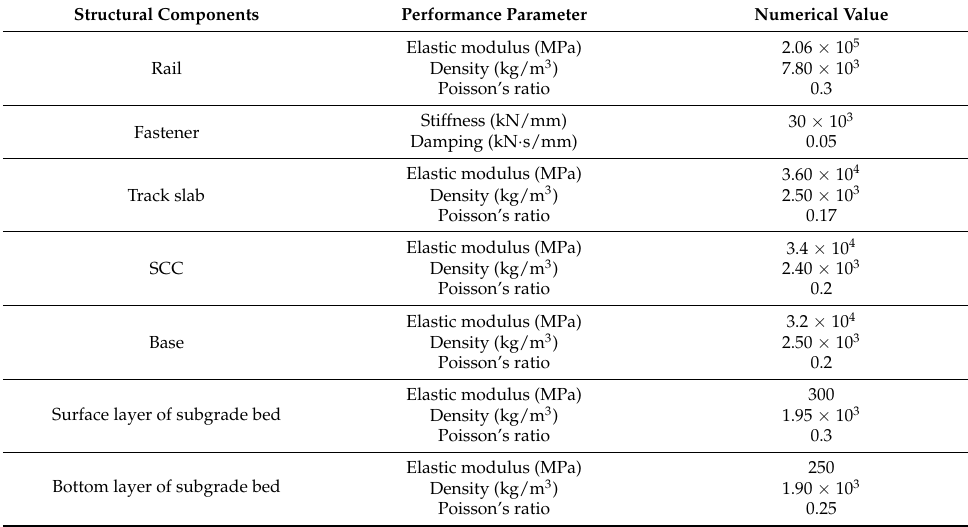
Table 1. Parameters of CRTSIII SBT structure